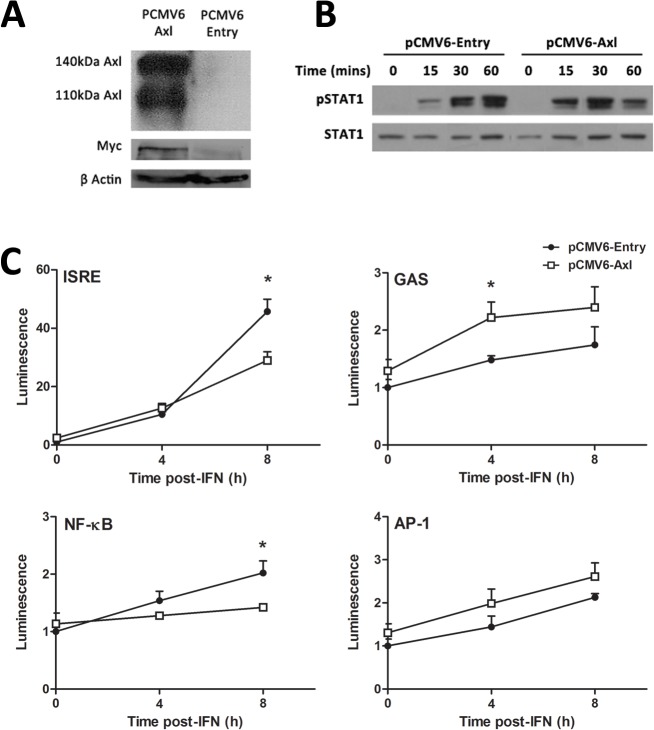
AXL overexpression dampens the response to IFNα.Stable transfection of Huh-7 cells with PCMV6-AXL was confirmed by western blot, using antibodies against AXL or the fusion Myc tag (A). Huh-7 cells overexpressing AXL induced a stronger but more transient phosphorylation of STAT1 (B), with increased phosphorylation at 15 and 30 minutes post-IFN (50 u/ml), but a strong decrease at 1 h (2 replicates). ISRE and NFκB promoter activation was decreased almost 2 fold at 8 h post-IFN treatment in cells overexpressing AXL, while GAS activation were increased 2 fold at 4 h post-IFN treatment (C). No effect on AP-1 promoter activation was observed (* p<0.05). Data represents the mean and standard error of two biological replicates performed in duplicate.